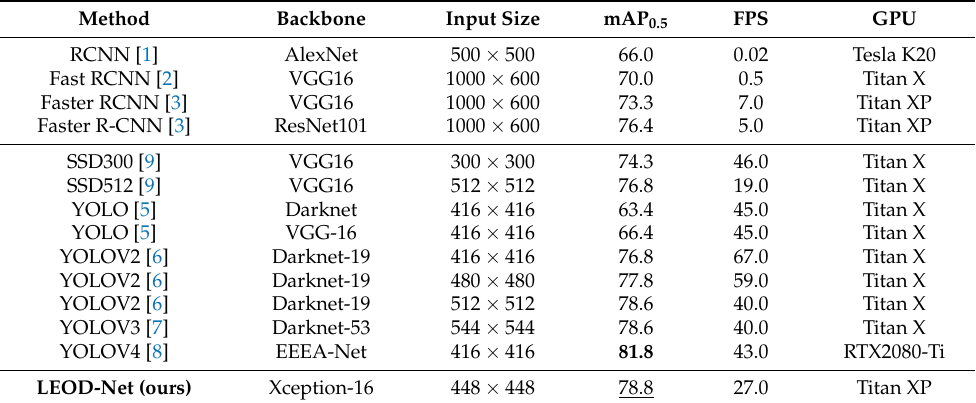
Table 4. Comparison with SOTA methods on the VOC2007 test set while training the model on VOC2007+VOC2012 trainval datasets together. The best value of AP box is shown in bold. The second best value is shown with underline.